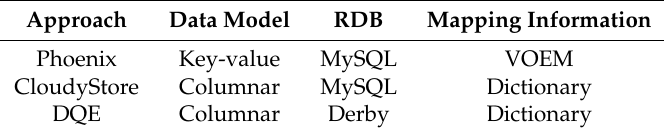
Table 2. Comparison of storage engine approaches.